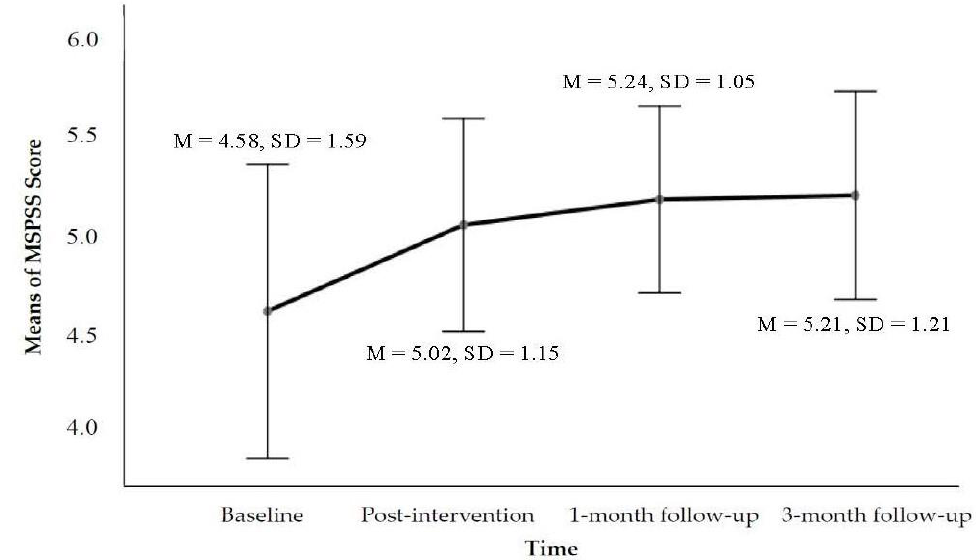
Figure 3. Estimated marginal means plot showing the changes of MSPSS scores across the four time points.